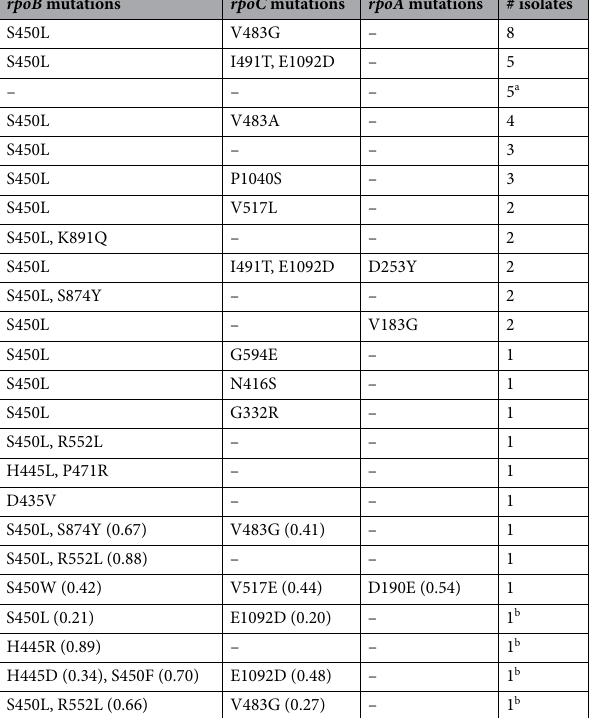
Table 3. Combinations of rpoB, rpoC , and rpoA mutations present in the 51 M. tuberculosis isolates. – Absent, () proportion of reads in a mixed infection and < 1. a Rifampicin susceptible. b Mixed